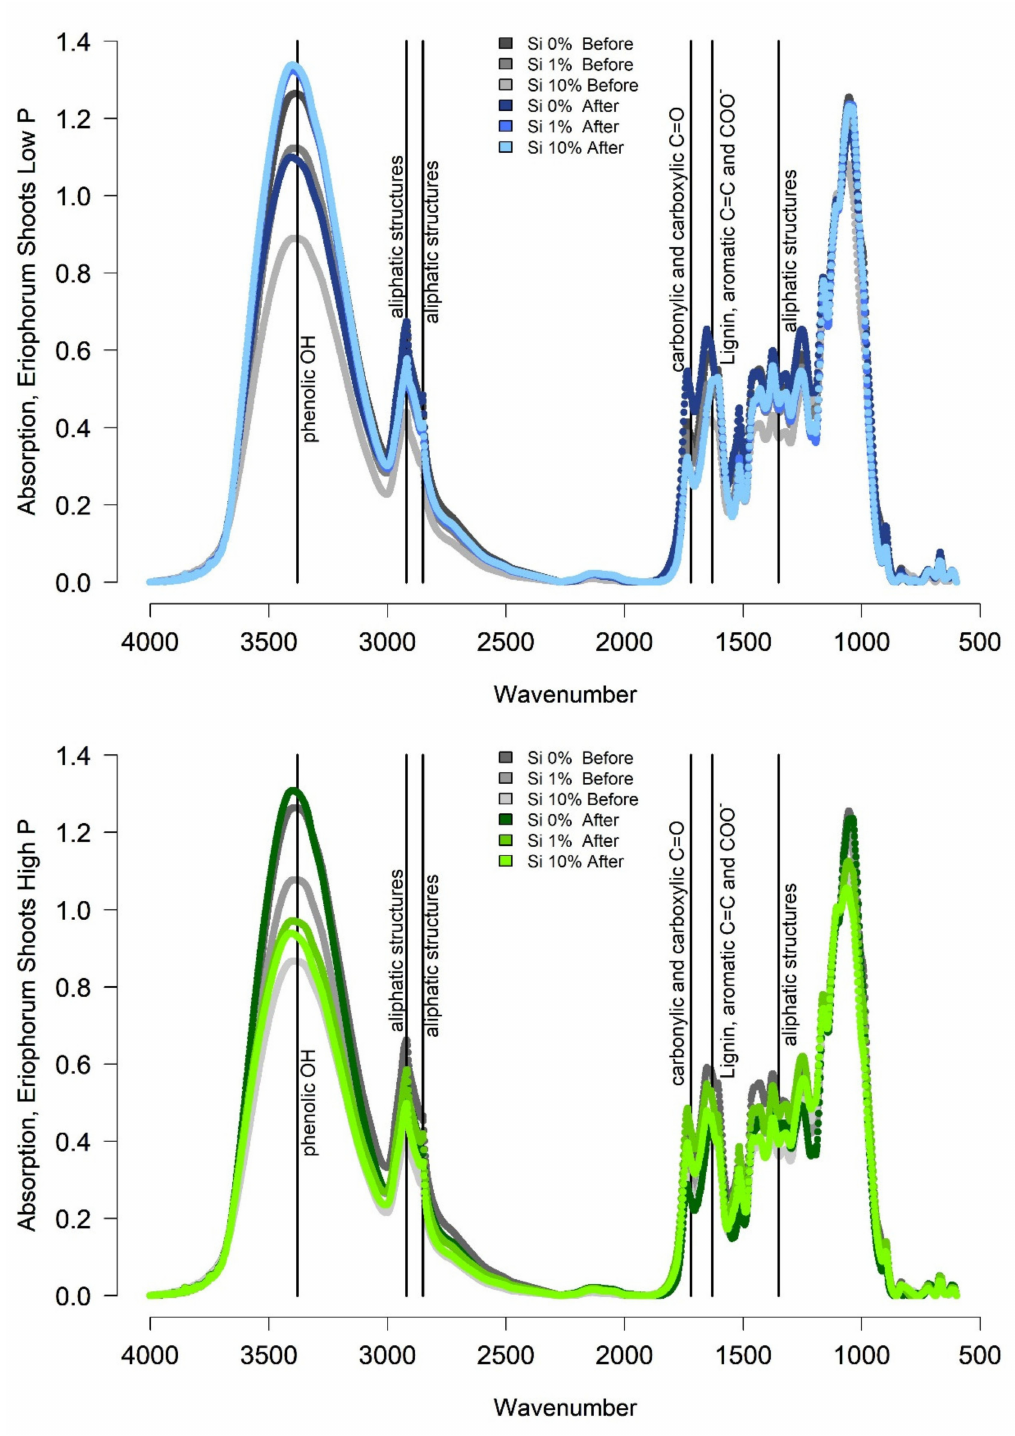
Figure 4. FTIR Spectra of Eriophorum shoots after the incubation in blue (low-P treatments) and green (high-P treatments). For the Si 0% both, the low and the high P spectrum, are the same, since no individual samples were available. Correspondent spectra from before the incubation are given in gray for orientation. The brightness of colors is according to the Si treatment. The absorption spectra, especially around wavenumber 3380, were higher for the “low-P Si 1%” and the “low-P Si 10%” treatment after the incubation compared to before due to a relative increase in the share of recalcitrant material (Figure 4). The “Si 0% low-P” spectrum rather showed a lower absorption around wavenumber 3380 after the incubation. For the high-P treatment group, the Si 0% and the Si 10% treatment